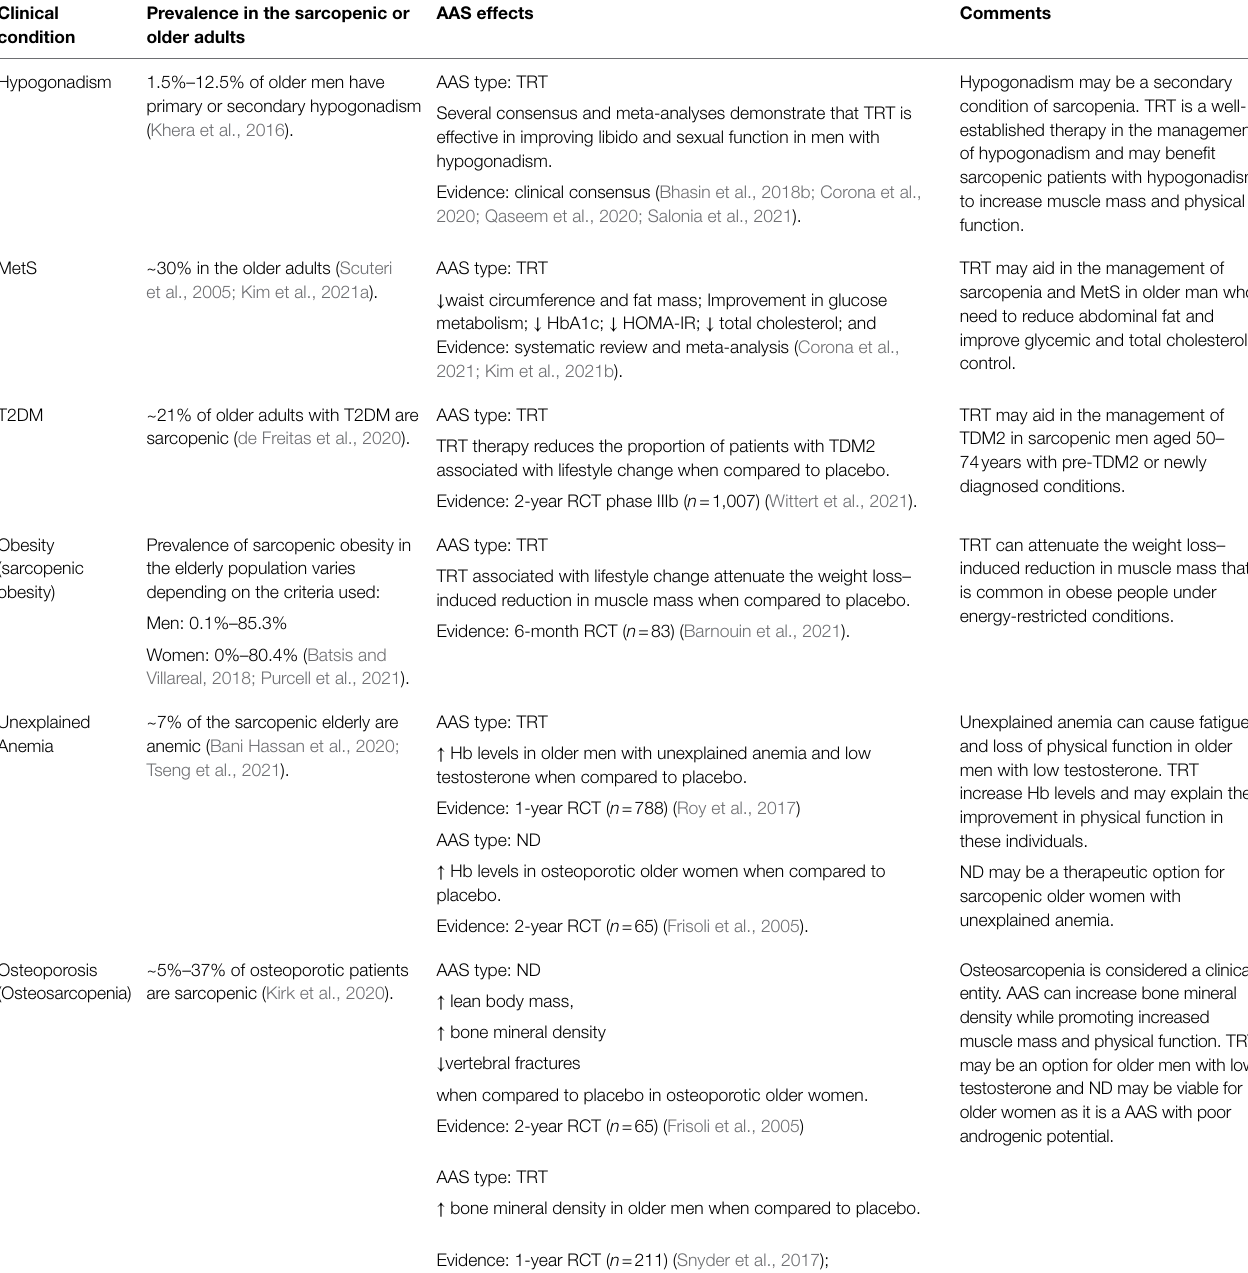
TABLE 1 | Clinical conditions coexist with sarcopenia and applicability of anabolic androgenic